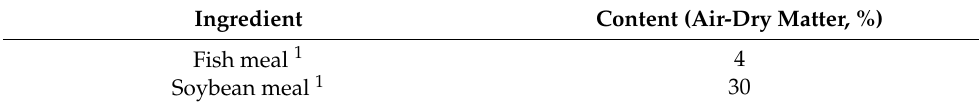
Table 1. Formulation and proximate composition of the experimental